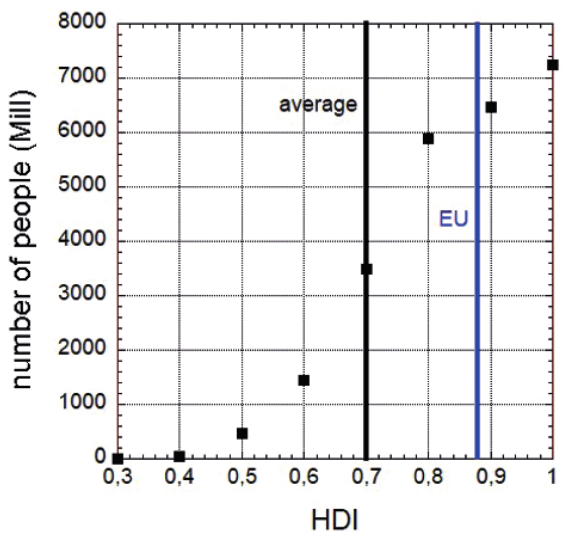
Fig. 4. – Number of people living below a specified HDI